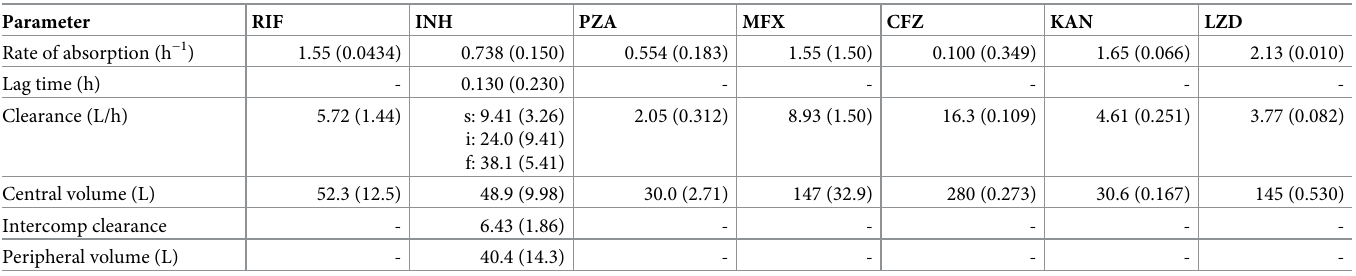
Table 2. Plasma PK parameters.